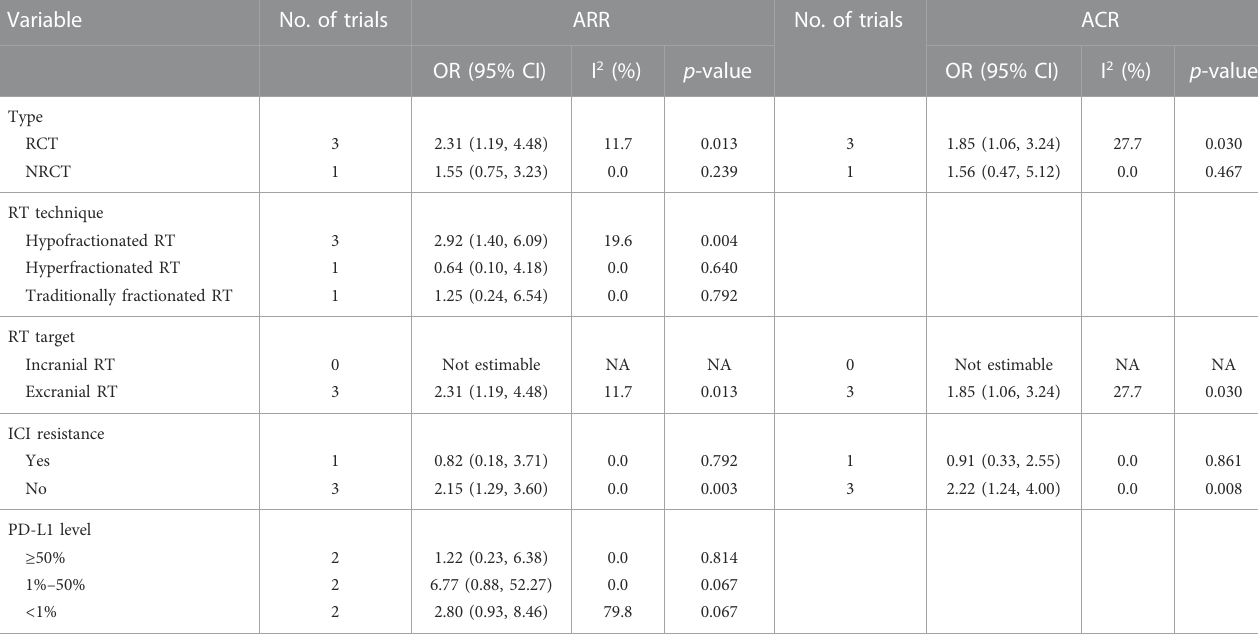
TABLE 3 Subgroup analysis of ARR and ACR of RT combined with ICIs versus ICIs alone in mNSCLC.